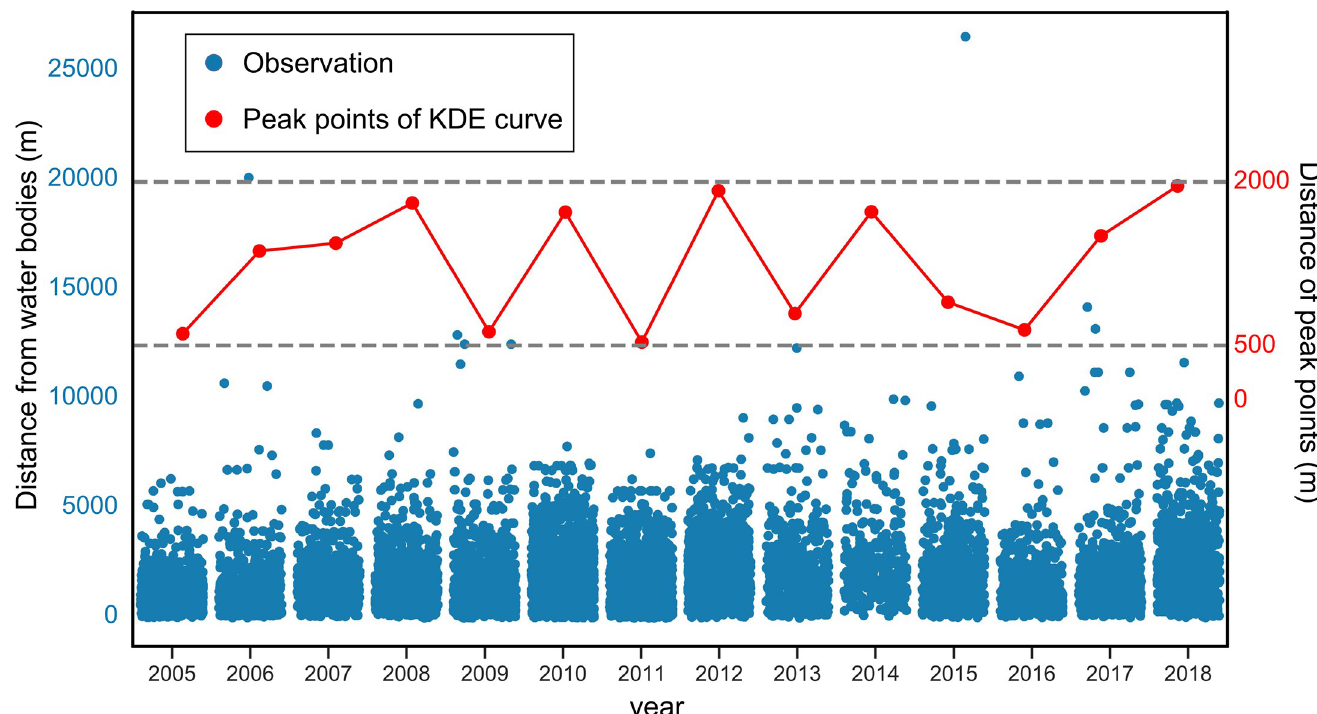
Fig 11. Dynamic change in the peak points of annual KDE curves. These curves reflect the distance of HFRS cases from water bodies in Xi’an City.